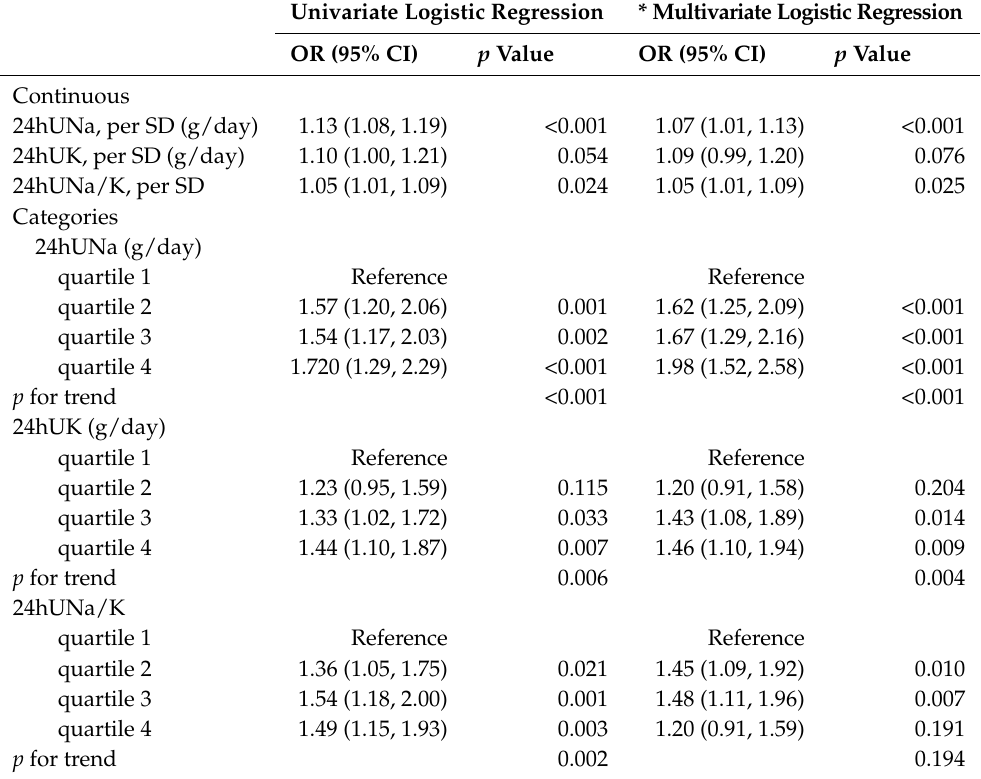
Table 3. Association between sodium, potassium, sodium: potassium ratio, and the 10-year CVD risk. Univariate Logistic Regression * Multivariate Logistic